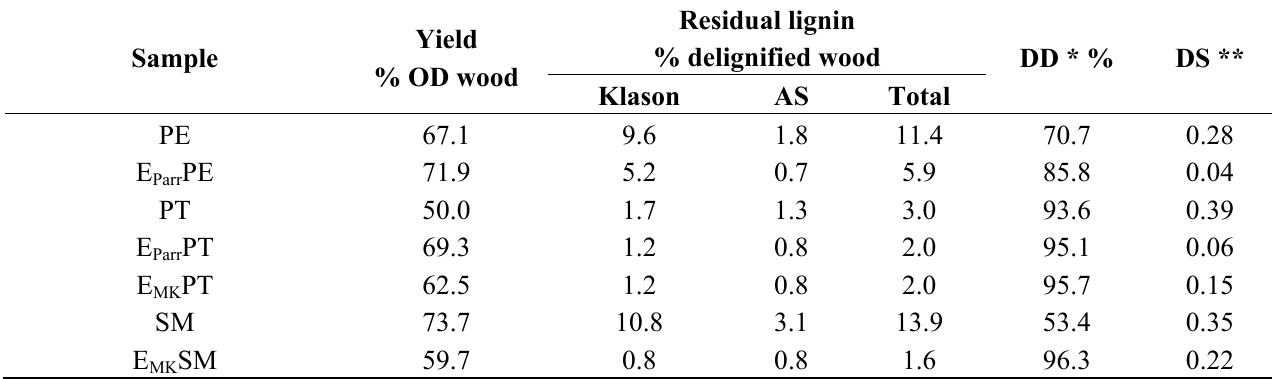
Table 3. Comparative results of AWO